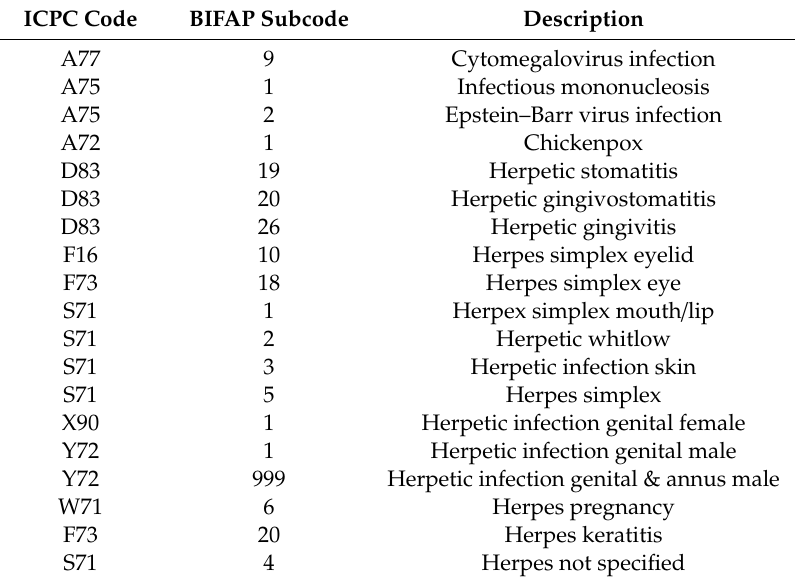
Table A2. International Classification of Primary Care (ICPC)-Base de datos para la Investigaci ó n